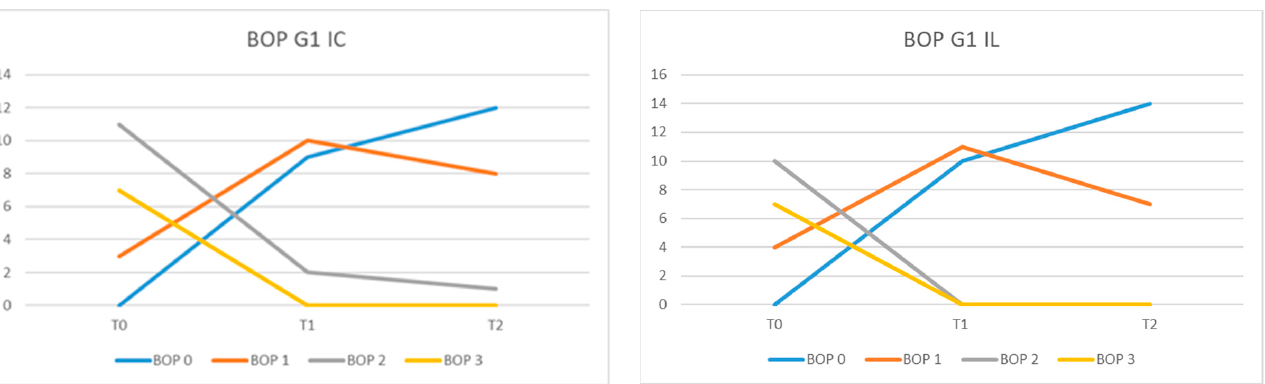
and 7 had BOP = 3. At moment T1, 10 patients had BOP = 0 and 11 patients BOP = 1, and